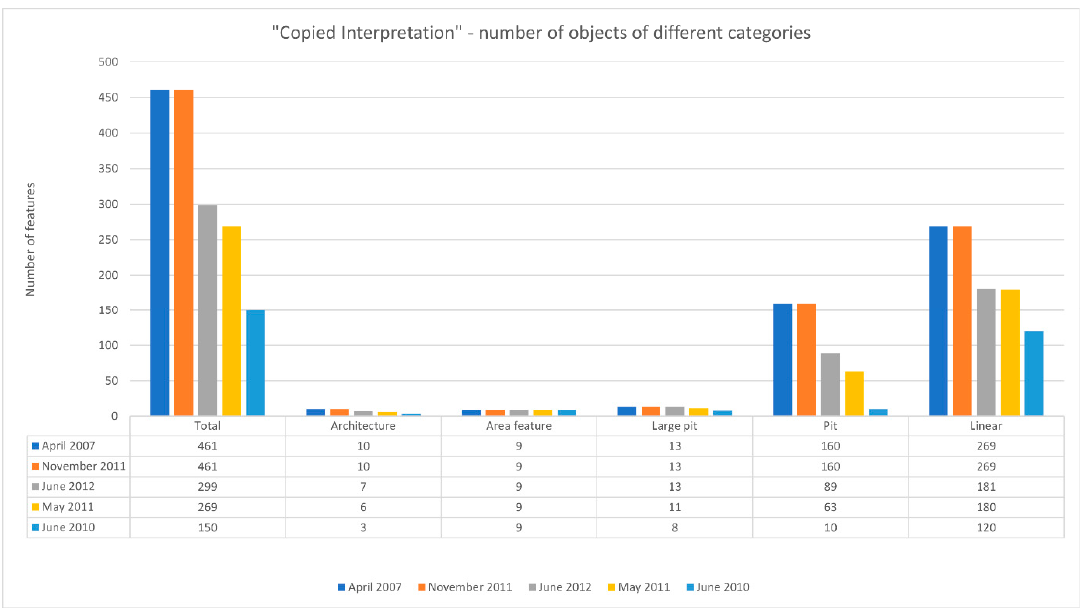
Figure 17. Number of individual features per category from “copied interpretation” drawings of each dataset. Table 4. Numbers of individual features from each “copied interpretation” drawing.